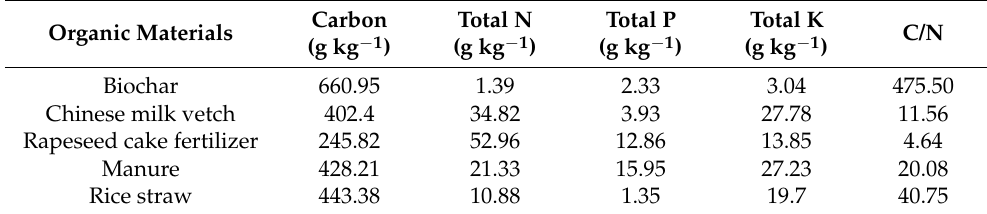
Table 1. The main nutrients in the different organic